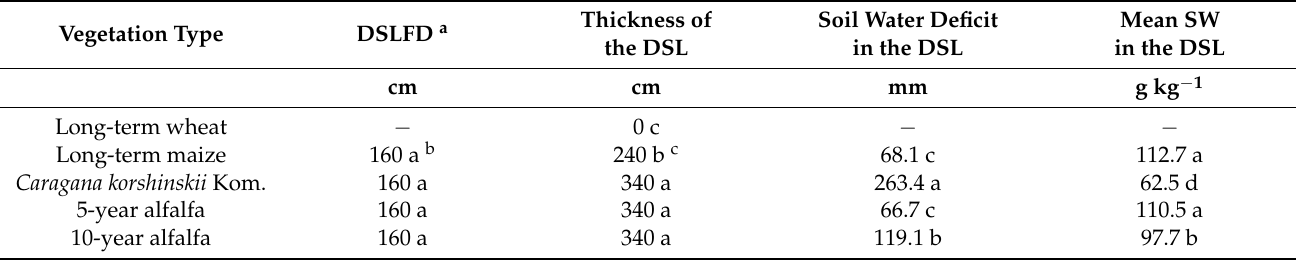
Table 4. Effect of land use on soil desiccation